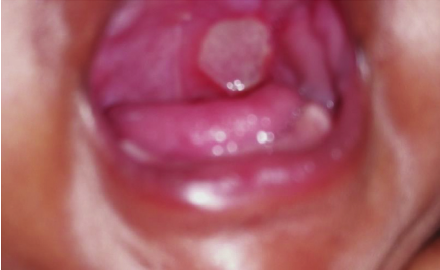
Figure 1: Appearance of the ulcer on the day of first